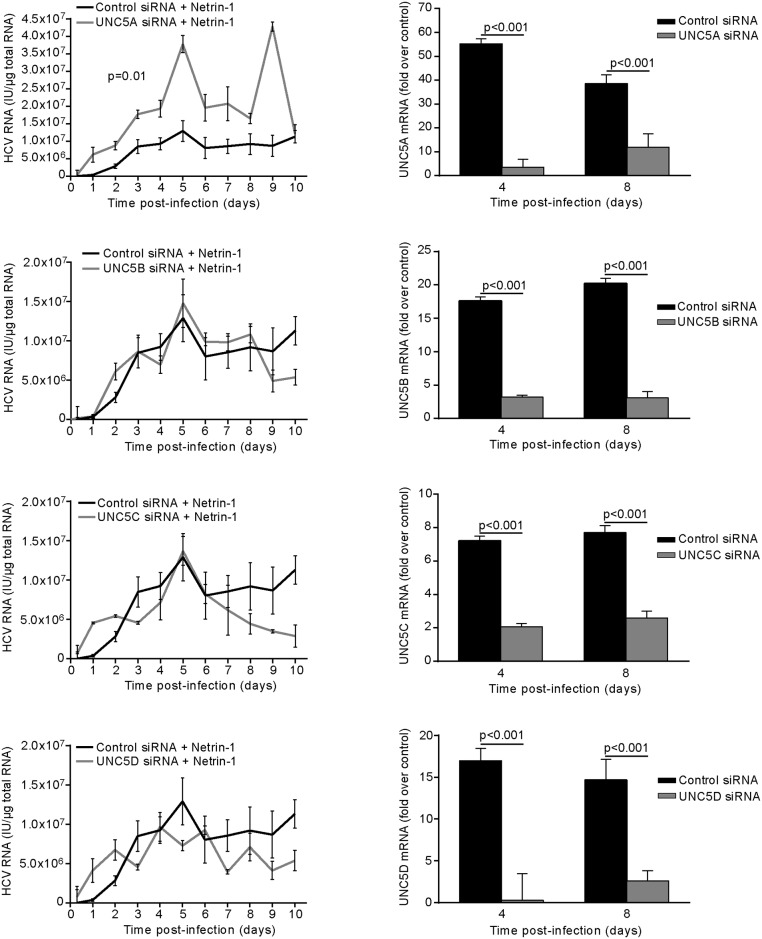
Netrin-1 increases HCV through the UNC5A receptor.Huh7.5 cells were transfected with siRNA against each UNC5 receptor or with a nontargeting control siRNA and infected at a MOI of 0.1 24 h after seeding. Cells were then trypsinized at day five post-infection before undergoing a second siRNA transfection. Recombinant soluble Netrin-1-Fc was added to the medium 12 h after transfection. Intracellular HCV RNA was quantified by RT-qPCR at each time point (left-hand graphs; data are represented as mean ± standard deviation, n = 3, Wilcoxon test, p < 0.05), while siRNA-mediated knockdown was quantified for each UNC5 transcript on days four and eight post-infection by RT-qPCR (right-hand graphs; data shown as mean ± standard deviation, n = 3). The underlying data for panels in this figure can be found in S1 Data.